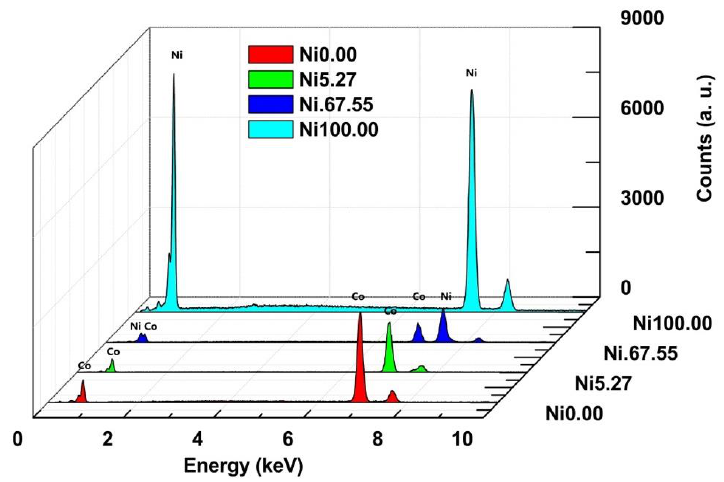
Figure7. EDSspectraofNi-Coalloynanowireswithdi ff erentcompositionobtainedbyelectrodeposition in polycarbonate